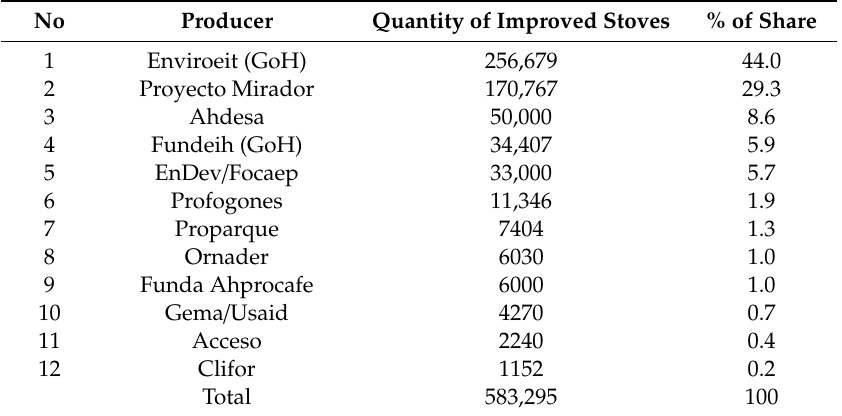
Table 1. Producers and improved stoves installed to December 2017 (Data from